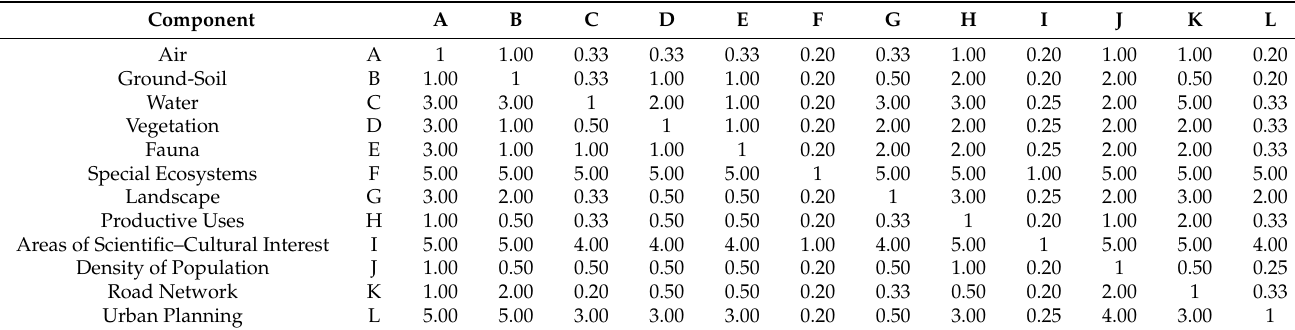
Table 6. Matrix of pairwise comparison for the ophitic outcrops in Cantabria.